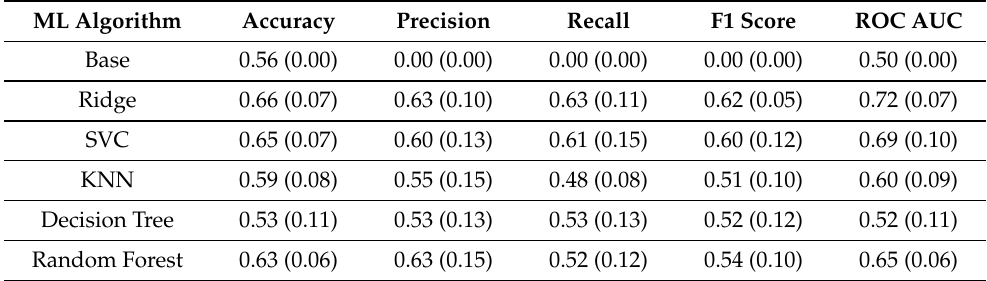
Table 8. HO prediction results (classification problem) using U-F features. Nested cross-validation with 10 outer and five inner splits. Classification problems on two classes: (a): High_HO (High Hedonic Orientated) and (b): Low_HO (Low Hedonic Oriented). Numbers are the mean value of 10 outer splits. Numbers in parenthesis indicate the standard deviation values.